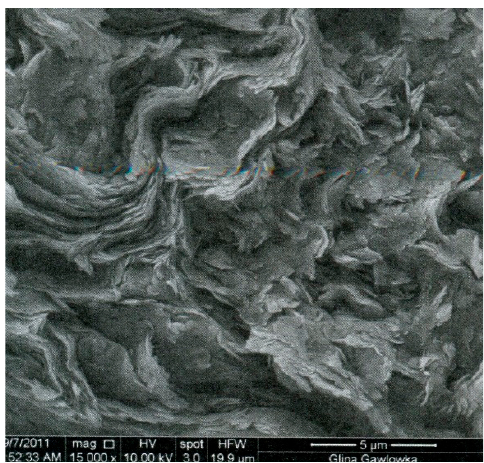
Figure 2. Clay minerals’ habit in the tested clay [49].